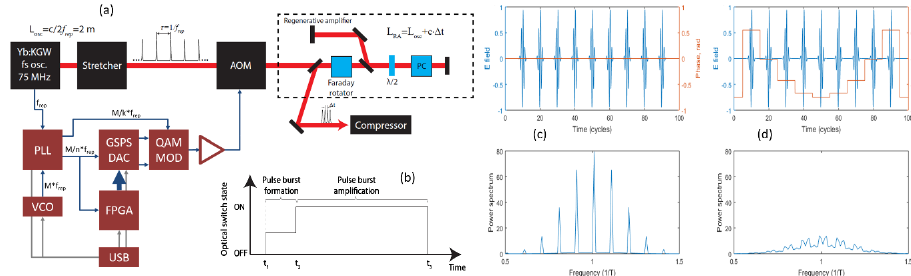
Fig. 1. Experimental scheme for regenerative pulse burst amplification using the Vernier effect. (a) Experimental layout. PC –Pockels cell. (b) Timing diagram of the high-voltage signal on the Pockels cell. (c) Formation of high-intensity spectral modes for bursts with repeated pulse phases. (d) Suppression of spectral modulation via pulse phase encoding by means of AOM